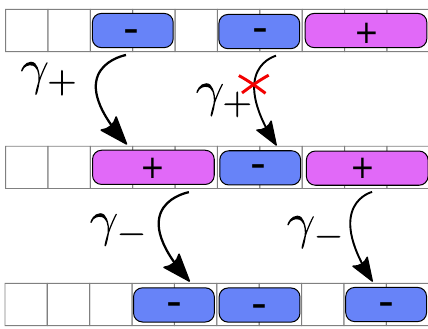
Figure 2: Sketch of the model with (cid:96) − = 2 and (cid:96) + = 3, showing how configurations can evolve. Movement is from left to right. Expanded particles ( + ) contract with rate γ − , whereas contracted particles ( − ) expand with rate γ + provided there are at least ∆ (cid:96) = (cid:96) + − (cid:96) − empty sites ahead of